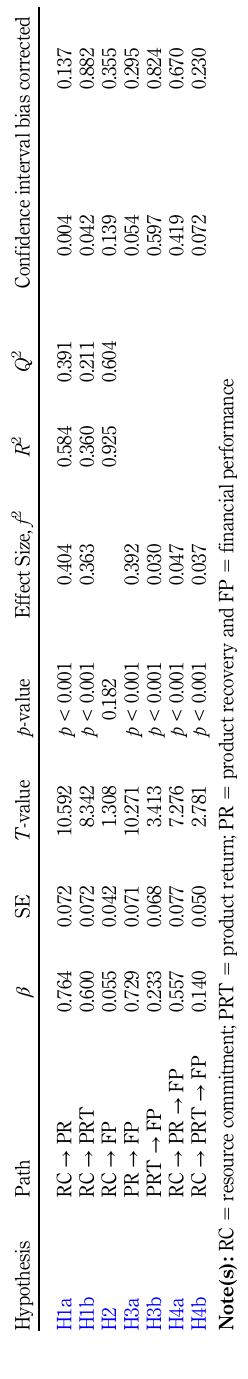
Table 3. Summary of hypotheses testing of initial PLS path